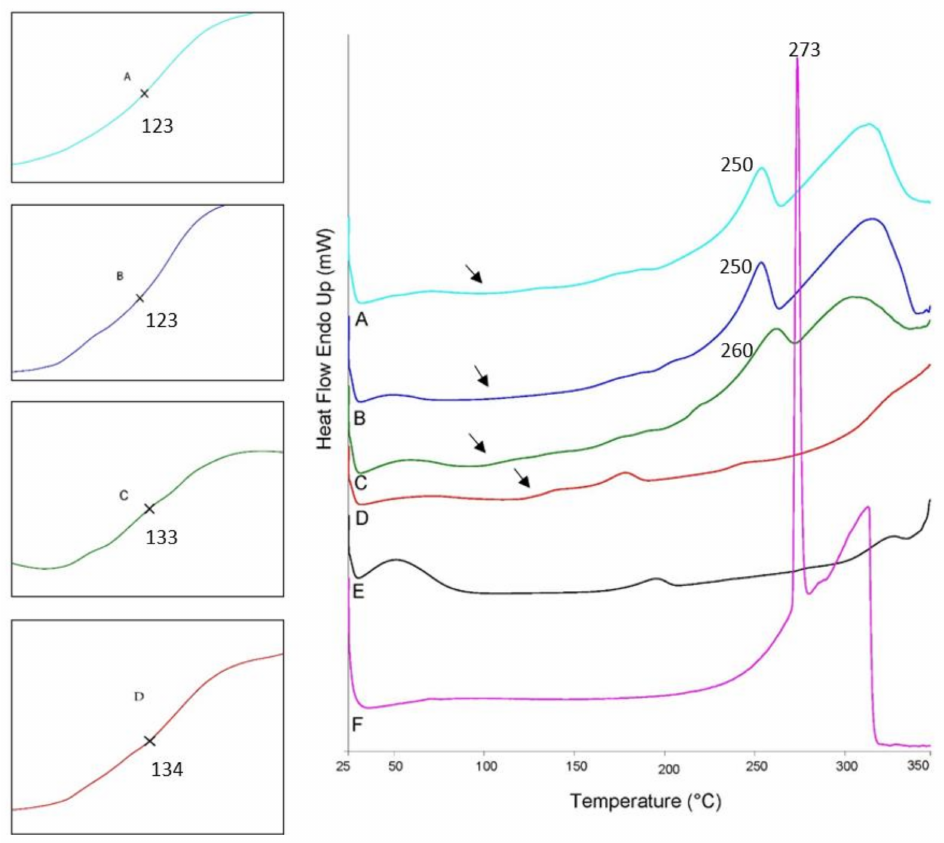
Figure 1. DSC thermograms for raw materials and tablets of F2: ( A ) printed tablets, ( B ) HME tablets, ( C ) PM tablets, ( D ) EC, ( E ) HPC, ( F ) theophylline. Arrows refer to the positions of glass transitions that are shown on a larger scale on the left side of the